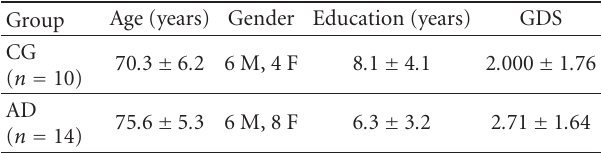
Table 1: Mean ( ± S.D.) demographic profiles of the subject populations.